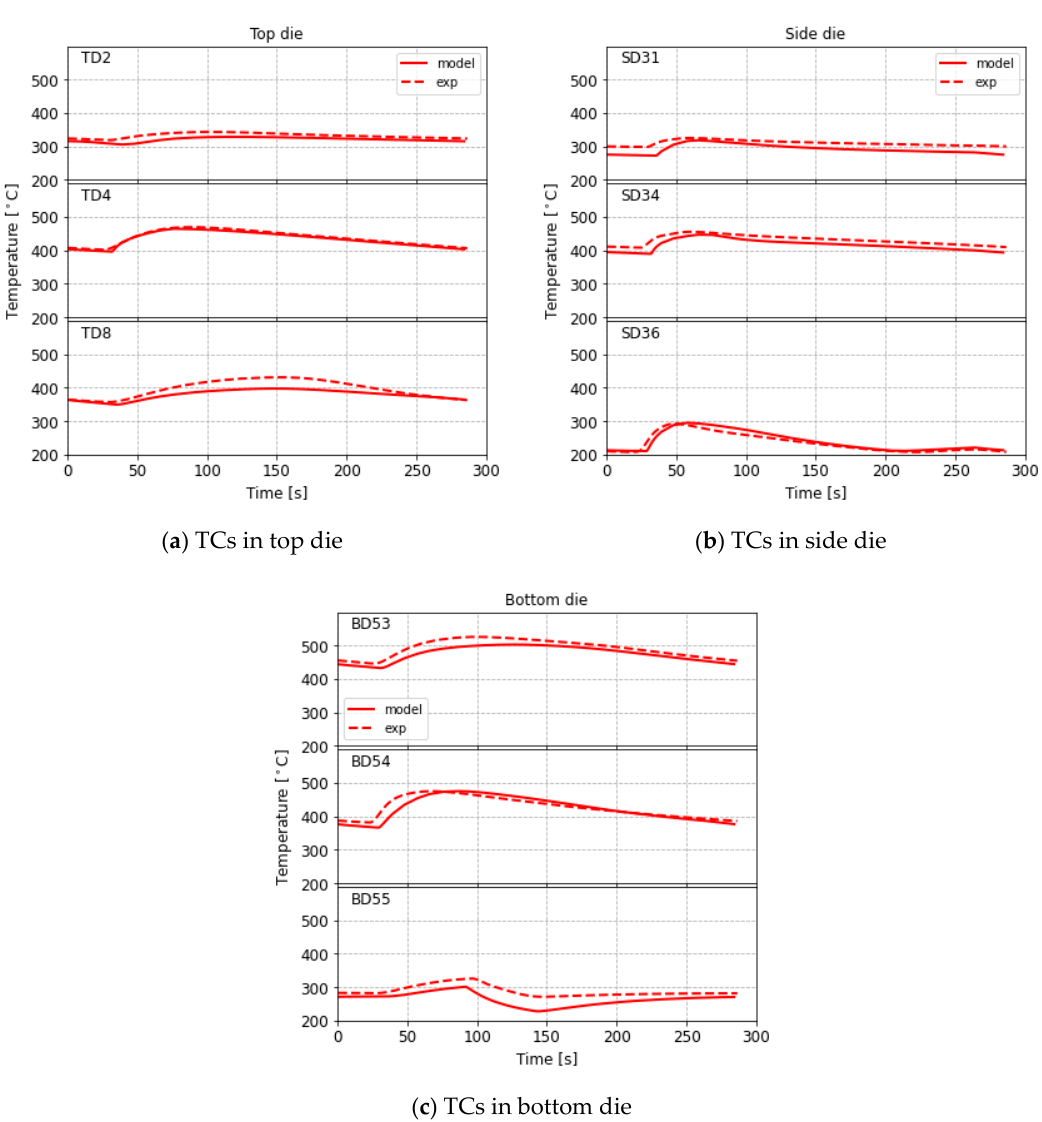
Figure 21. In-die temperature comparison between the model and measured data for the second die/wheel geometry.